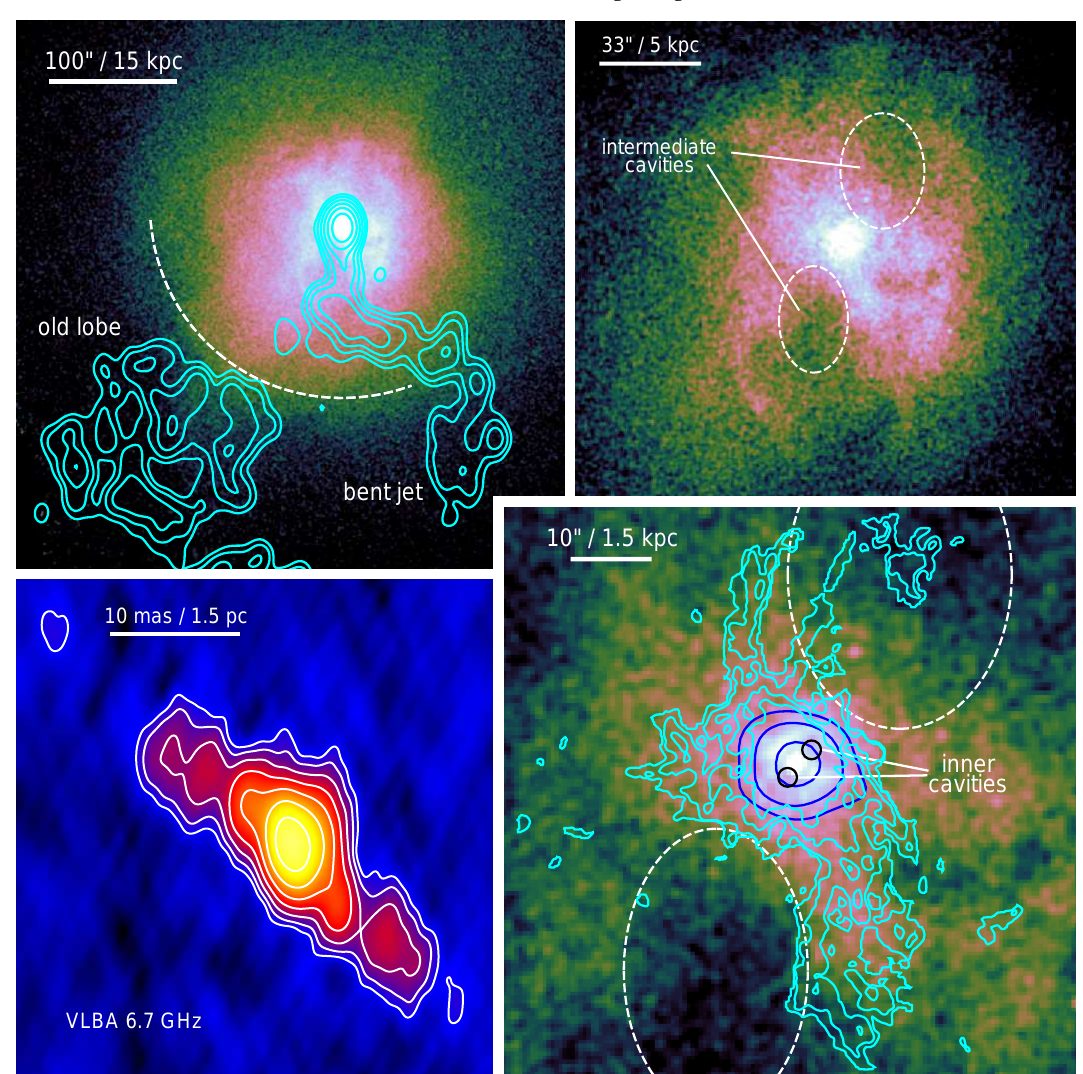
Figure 8. Multiple cycles of AGN feedback in the NGC 5044 galaxy group. The upper left panel shows the 0.5–2 keV Chandra image with GMRT 235 MHz contours overlaid. These reveal an old, bent radio jet and detached lobe from a prior AGN outburst, whose structure has been affected by the sloshing front marked with a dashed line. The upper right panel zooms in to show more detail of the complex of cavities and cool filaments in the group core. The lower right panel zooms in further, with contours showing the MUSE H α (cyan) and ACA diffuse CO (blue) in the densest parts of the X-ray filaments and core. The lower left panel shows parsec-scale VLBA 6.7 GHz radio emission in the nucleus of the galaxy, evidence of a new cycle of AGN jet activity (adapted from